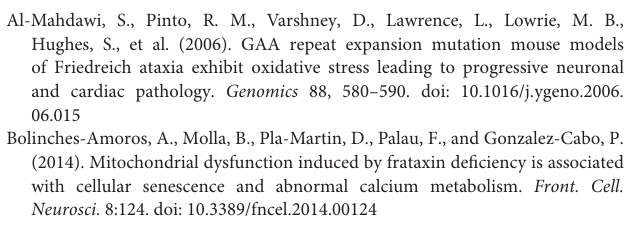
FIGURE S1 | Frataxin KD in cardiomyocytes. (A) HL-1 cells transfected with Scr and FxnKD. From top left Scr YFP cells (green), and labeled with Fxn antibody, showing red fluorescence. Bottom left, DAPI to label the nuclei (blue) and merge. On the top right panel YFP positive cells in FxnKD and labeled with Fxn antibody, showing a very low red fluorescence due to the KD. Bottom right, DAPI to label the nuclei (blue) and merge. (B) The histogram shows the quantification of the Fxn red fluorescence detected in the dishes and comparing Scr and FxnKD. FxnKD showed a significant decrease of the Fxn level ( ∗ p < 0.05). Scale bars (20 µ m). (C) H9c2 cells transfected with scr and FxnKD. From top left Scr YFP cells (green), and labeled with Fxn antibody, showing red fluorescence. Bottom left, DAPI to label the nuclei (blue) and merge. On the top right panel YFP positive cells in FxnKD and labeled with Fxn antibody, showing a very low red fluorescence due to the KD. Bottom right, DAPI to label the nuclei (blue) and merge. (D) The histogram shows the quantification of the Fxn red fluorescence detected in the dishes and comparing Scr and FxnKD. FxnKD showed a significant decrease of the Fxn level ( ∗∗ p < 0.005). Scale bars (20 µ